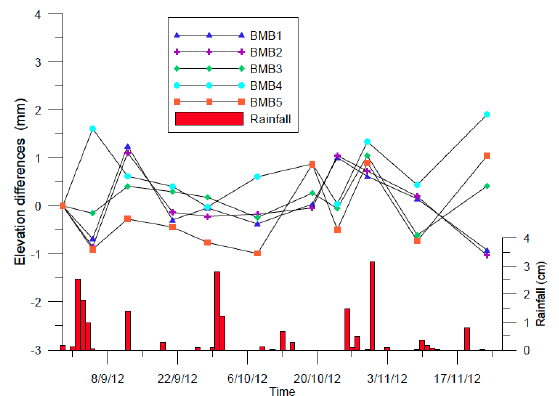
Figure 5. Elevation differences between two contiguous measurement epochs (h ti -h ti-1 ) for benchmarks fixed in masonry of old buildings at unknown foundation